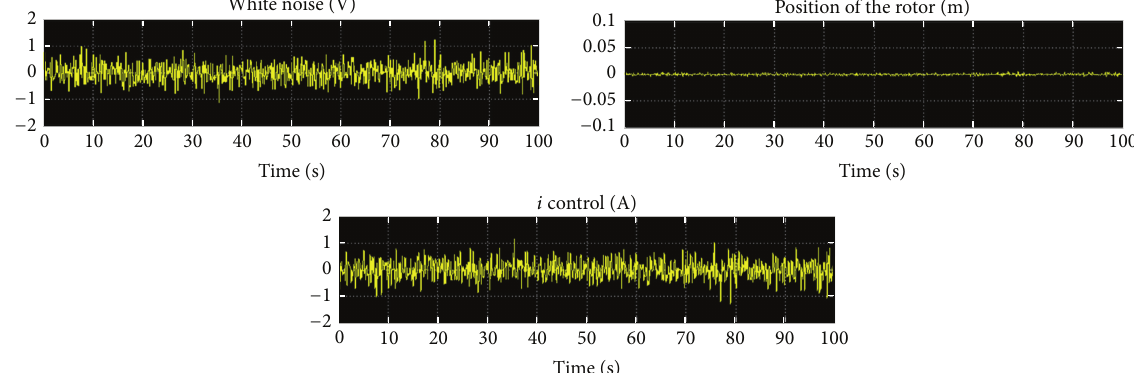
Figure 10: System response with PD controller with proportional gain of 192.8569 and differential gain of 7.8867 and white noise of 0.01